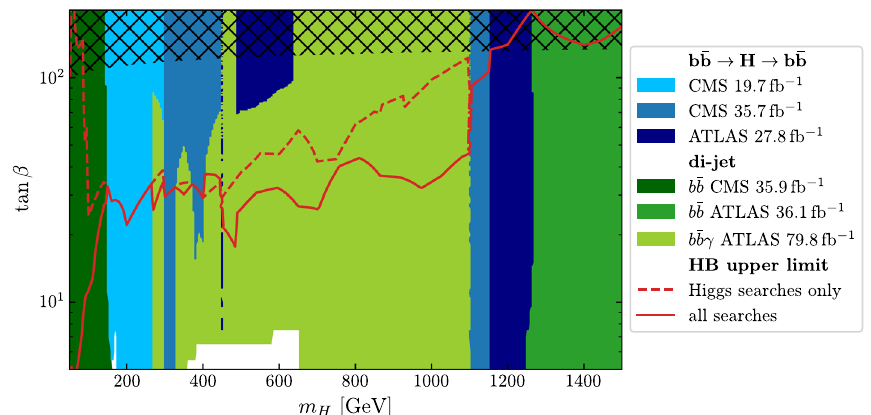
Fig. 5 LimitsfromsearchesfortheheavyHiggsboson H intheflipped 2HDM in the ( m H , tan β ) plane. The color code indicates the most sen- sitive limit for each parameter point. The blue limits are Higgs searches in the b ¯ b → H → b ¯ b channel [48,49,65], while the green limits are newly implemented di-jet searches in the b ¯ b [22,26] and b ¯ b + γ [28]